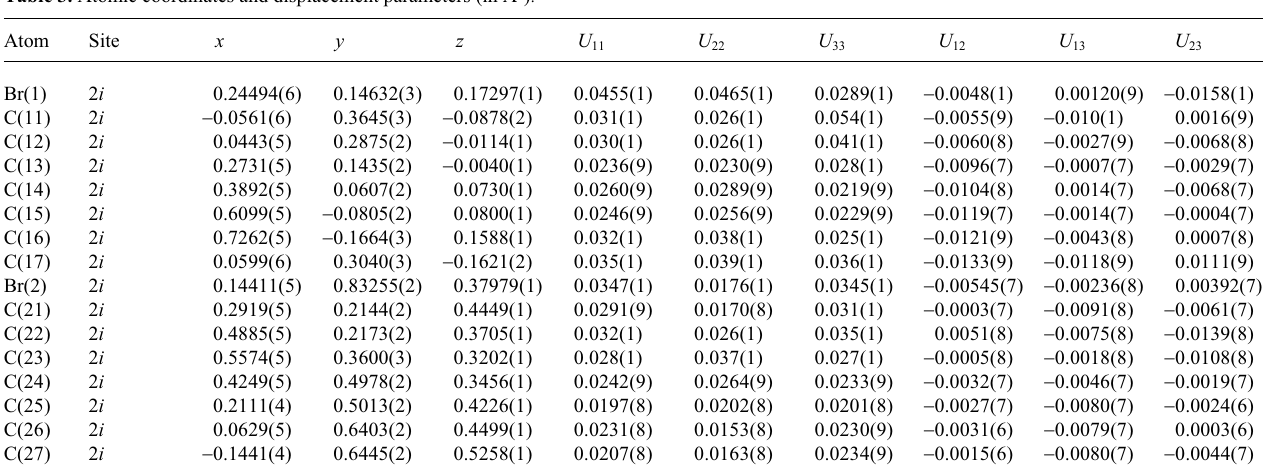
Table 3. Atomic coordinates and displacement parameters (in Å 2 ) .